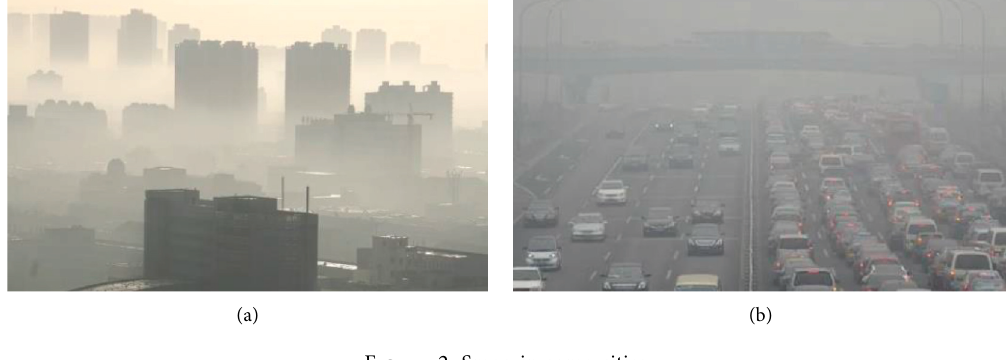
Figure 2: Smog in some